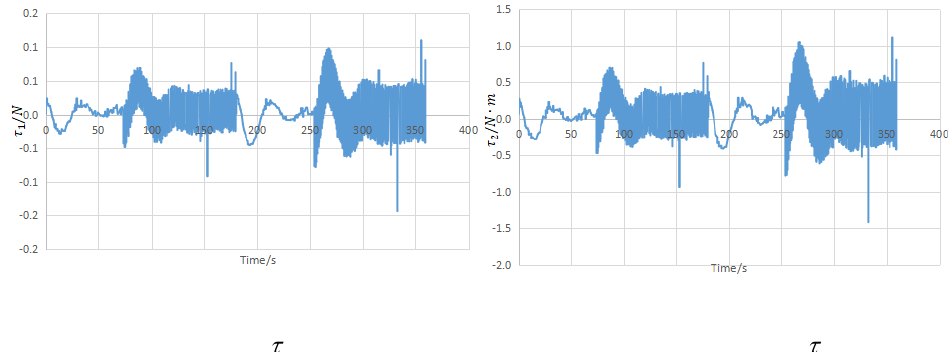
Figure 12. The outfield experiment control law ( τ 1 and τ 2 ).